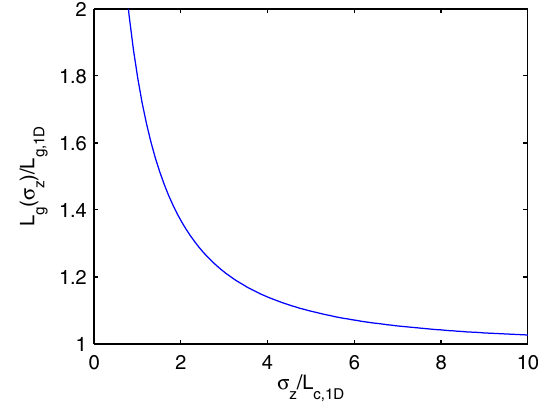
ð (cid:3) Þ =L as a function of g z g; 1D =L . z c; 1D